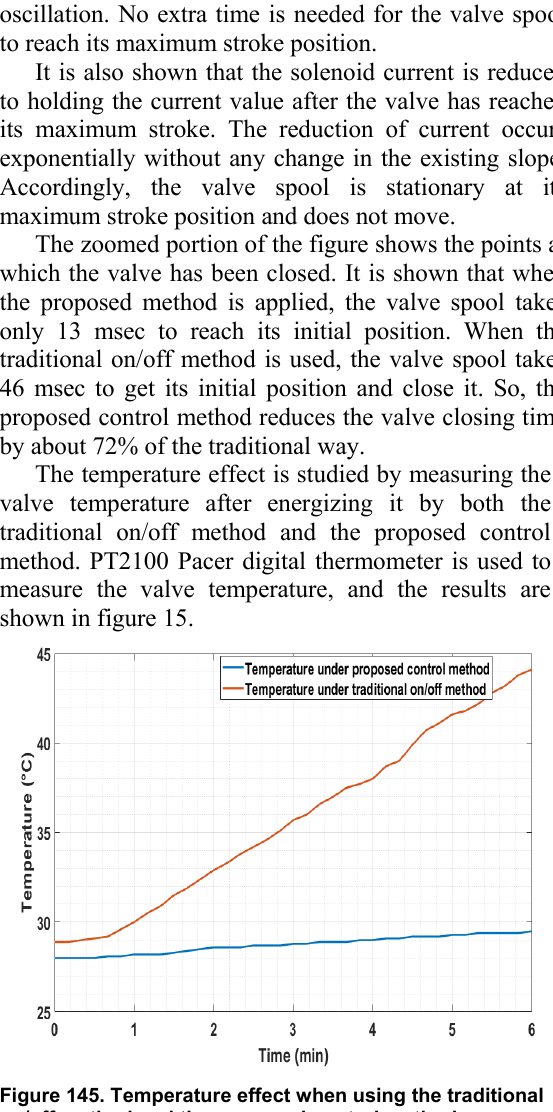
Figure 145. Temperature effect when using the traditional on/off method and the proposed control